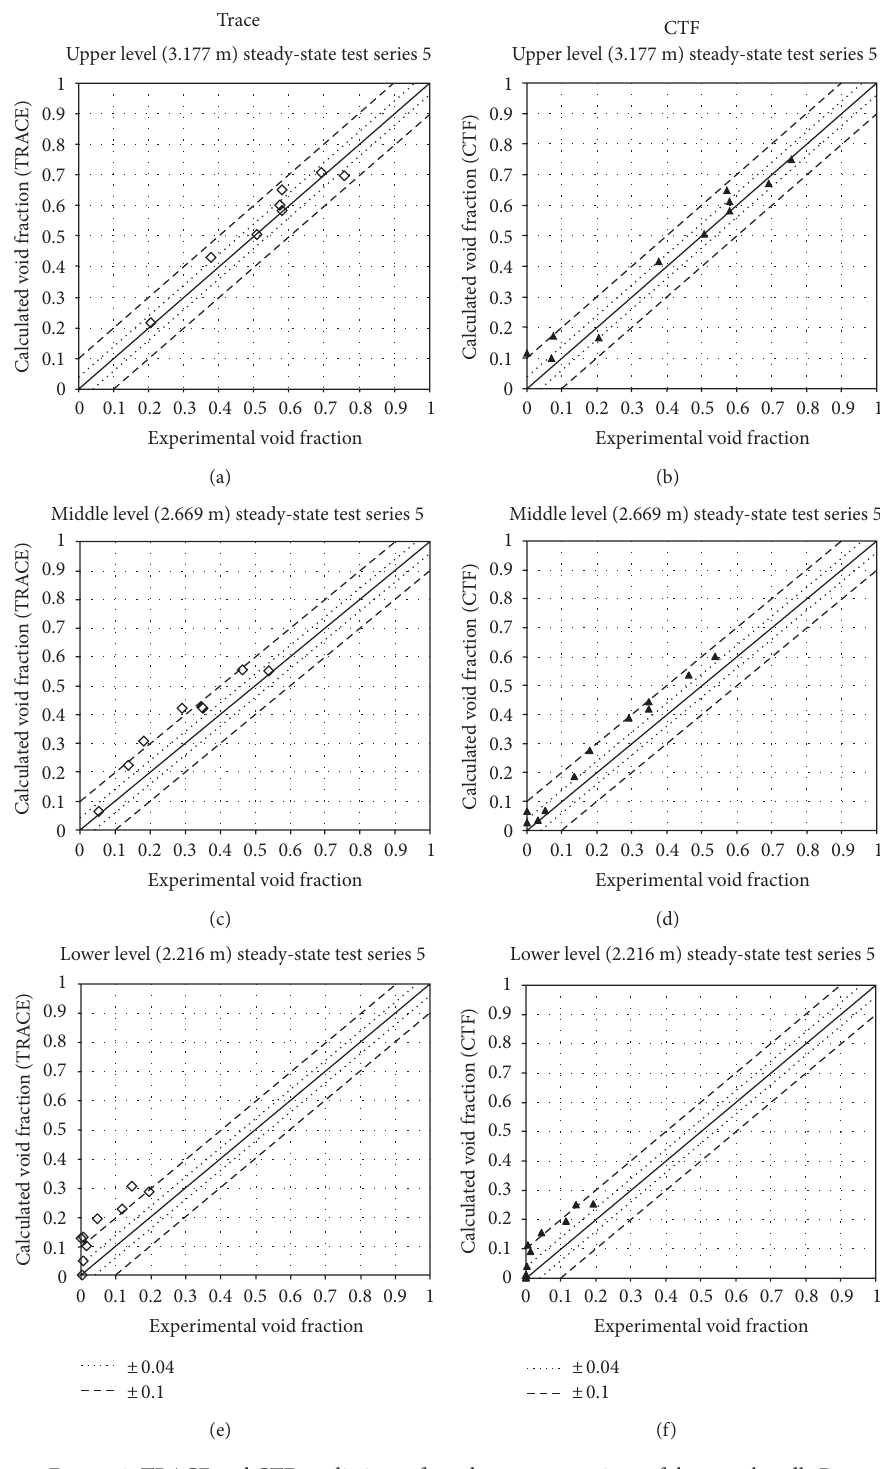
Figure 2: TRACE and CTF predictions of steady-state test series 5 of the 5 × 5 bundle B5.